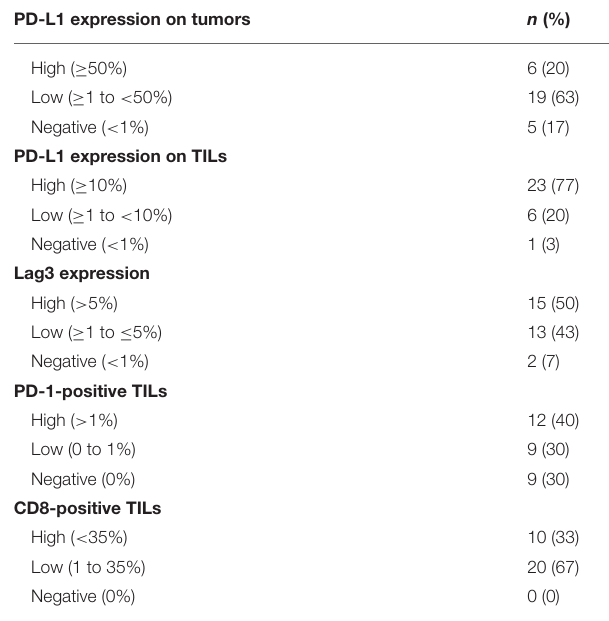
TABLE 2 | Immunohistochemical characterization of NPCs studied